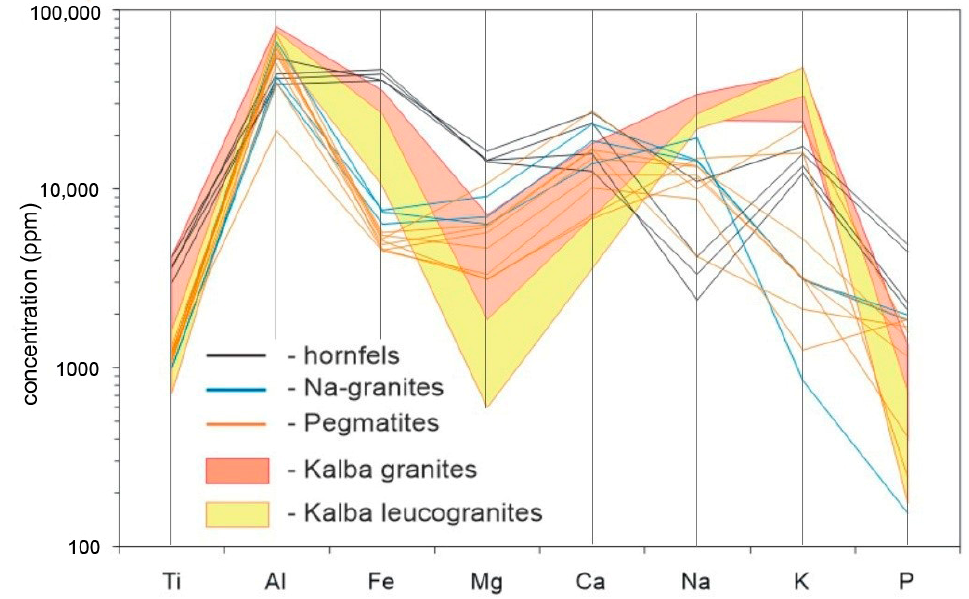
Figure 11. Distribution of main elements (concentrations in ppm) in hornfelses, Na-granites, and pegmatites of the Tochka deposit in comparison with the Kalba granites and leucogranites. The composition of the Kalba granites and leucogranites are taken from [24,47].